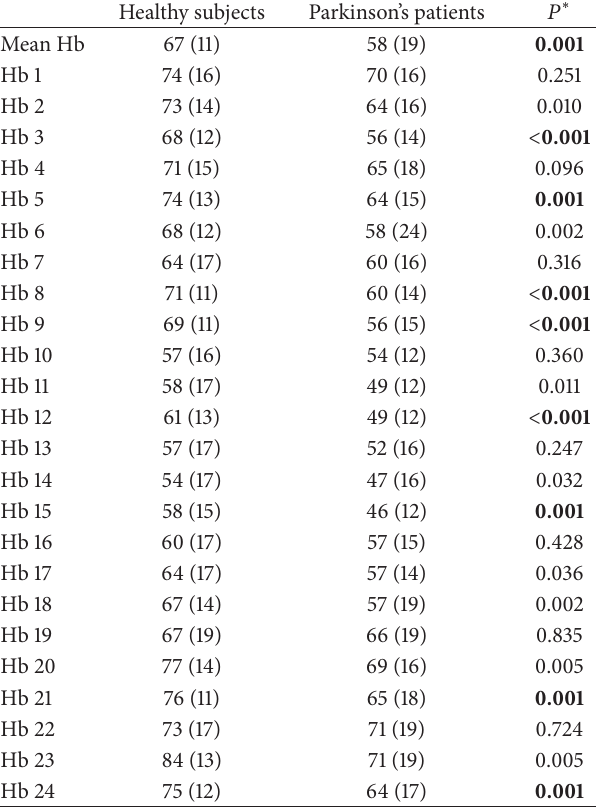
Table 2: Mean and standard deviation in parenthesis of hemo- globin’s percentage analysing optic disc photographs with Laguna ONhE program (optic nerve head hemoglobin) of Parkinson’s disease patients and healthy subjects and statistical significance of the comparison between both groups ( 𝑃